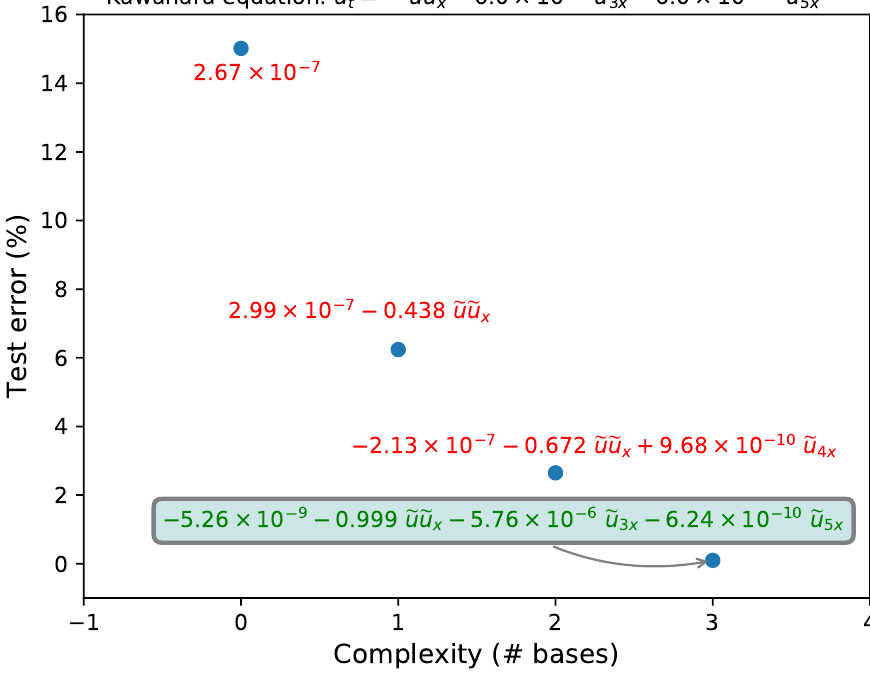
Figure 12. Predicted models with varied test error and complexity for Kawahara equation. Note: the basis u x is removed from the candidate